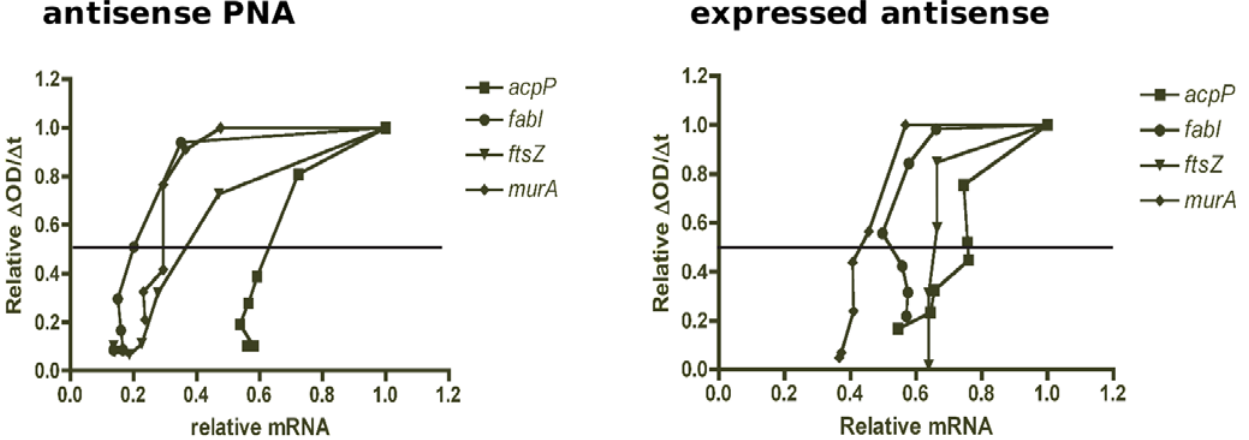
Figure 5. Determining the MTL 50 value of each gene. For each gene, mean relative mRNA and growth rate values from Figure 3 were transformed so that mean relative mRNA values were plotted against corresponding mean values of relative growth rates to obtain a curve. The curve of each gene allows an estimation of a transcript value (on the x-axis) at a growth reduction of 50% (y=0.5), that is, the MTL 50 value of the gene of interest. The MTL 50 value reveals stringency of an essential gene for growth.